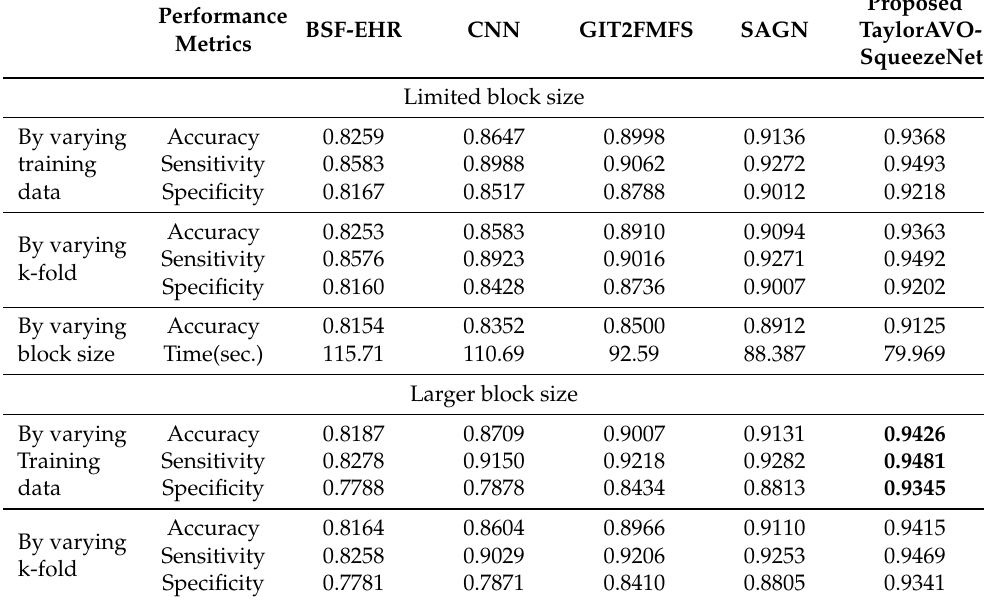
Table 3. The analysis of performance metrics for several